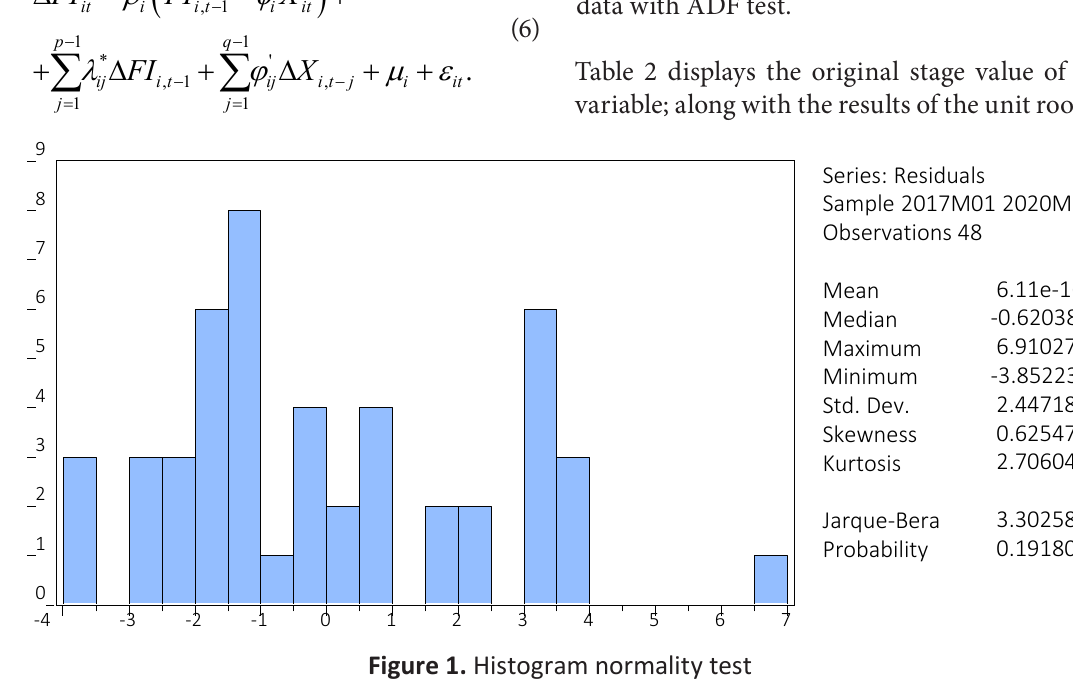
Figure 1. Histogram normality